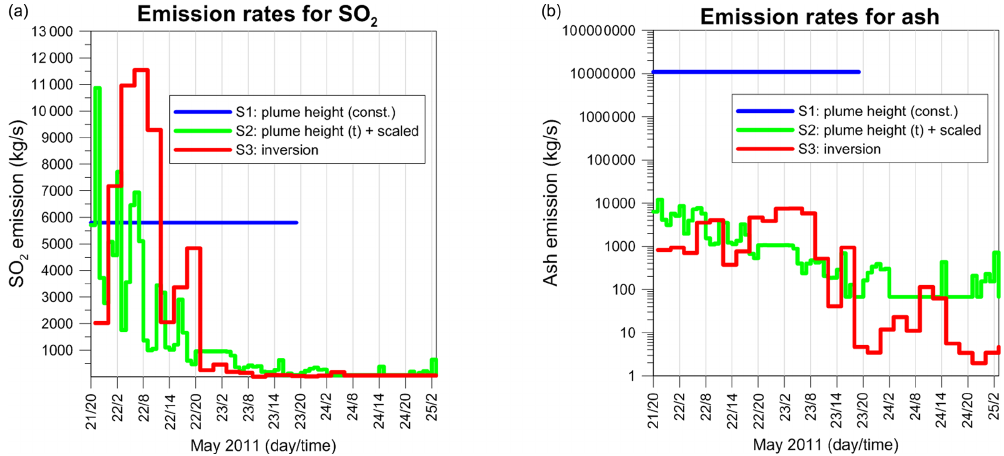
Figure 5. Emission rates for all three emission scenarios for SO 2 (a) and ash (b)